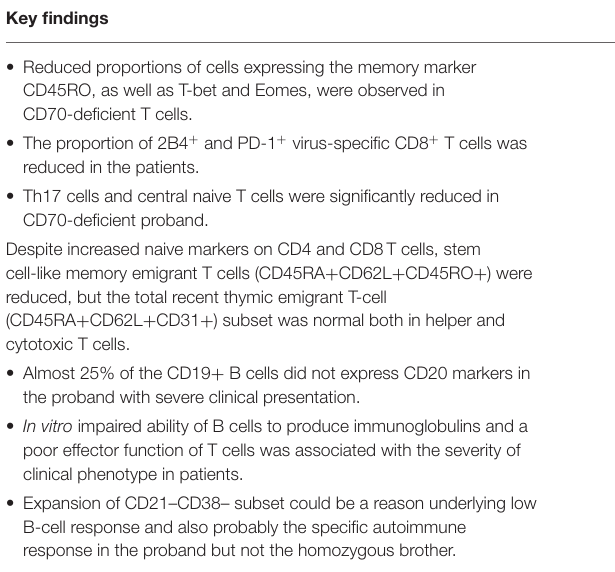
TABLE 2 | A summary of new findings of patients with CD70